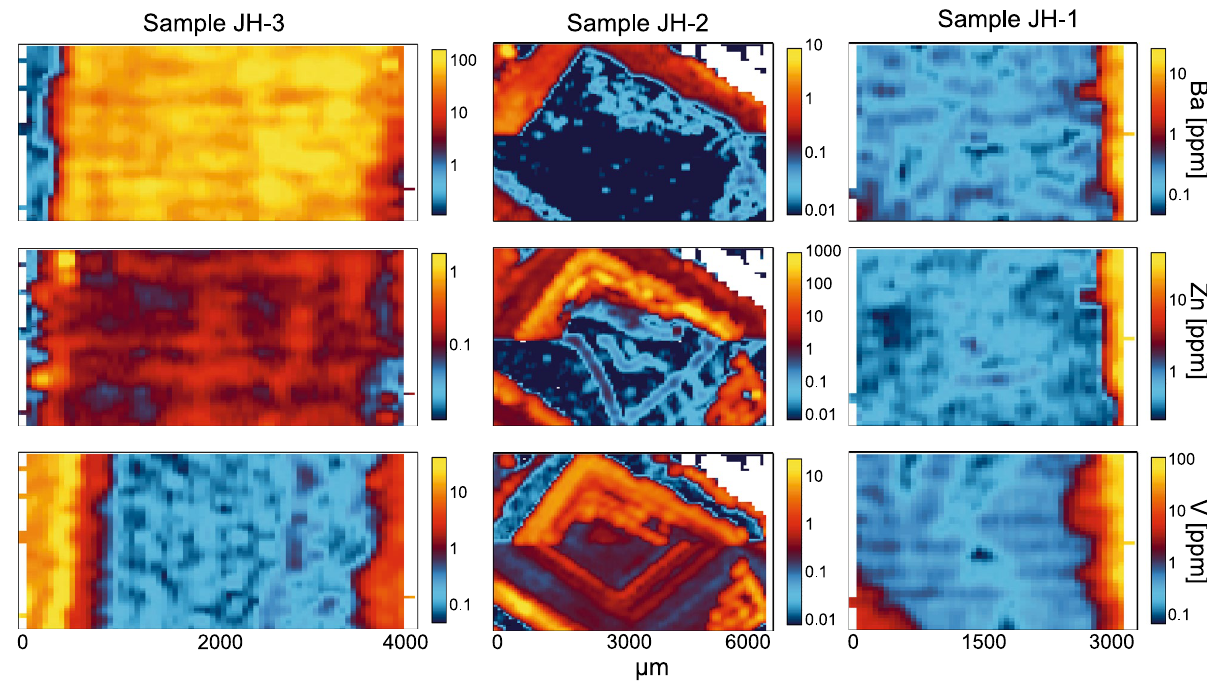
Figure 6. Images showing the elemental concentration (ppm) of barium, zinc and vanadium in samples JH-1, JH-2 and JH-3. Location of the elemental concentration maps are denoted by the black dashed boxes in Fig.